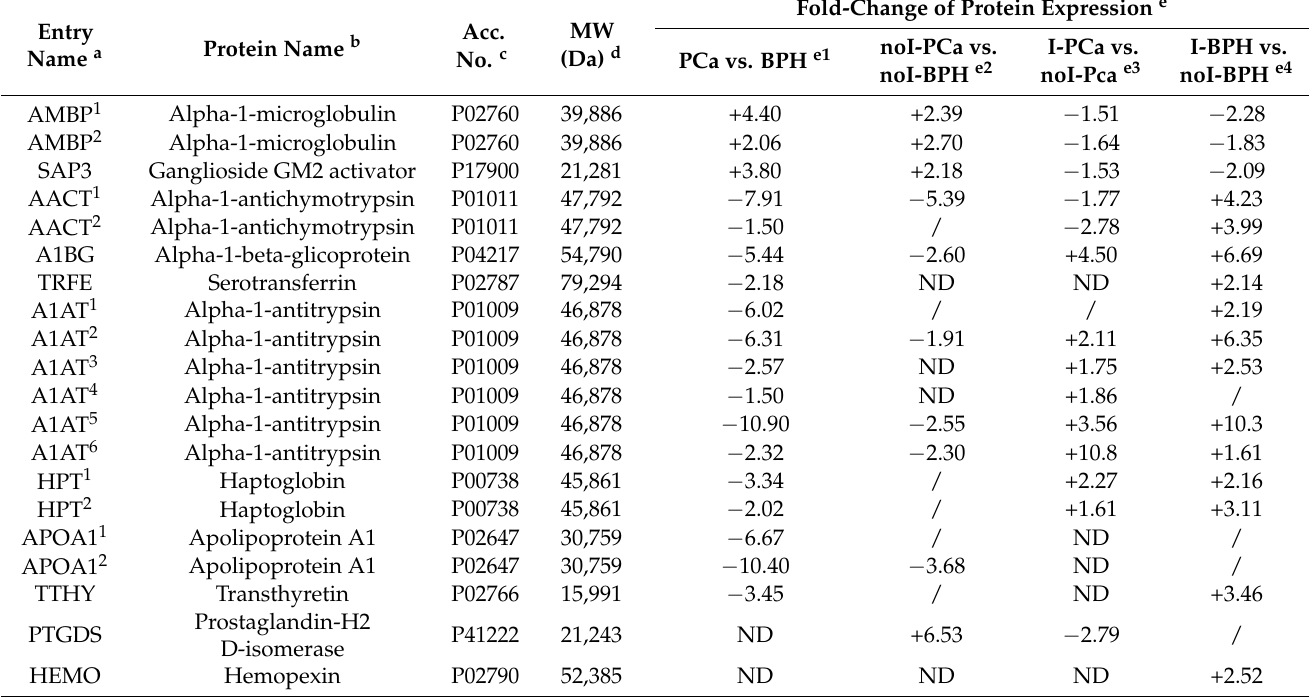
Table 3. Urinary proteins identified by ESI-Q-ToF-MS/MS